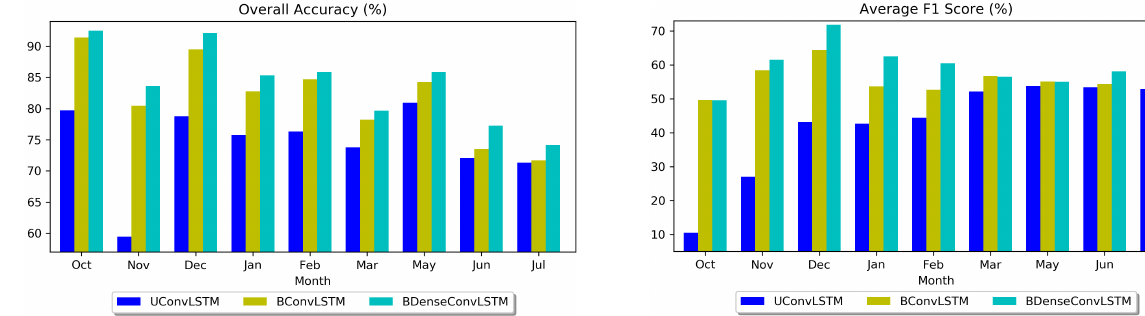
Figure 9. Average F1-Score for Campo Verde study area, computed in each date.